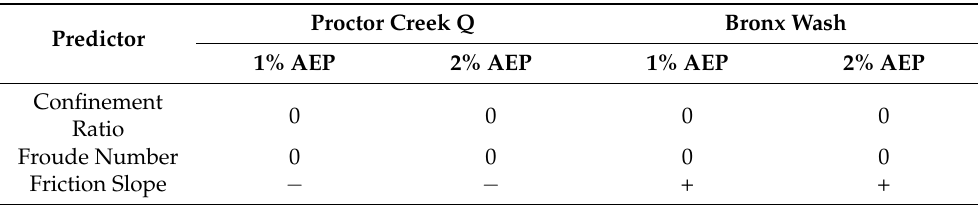
Table 4. General trends between depth errors in SUB and physical and hydraulic metrics. (+) indicates a positive trend, ( − ) indicates a negative trend, and (0) indicates no apparent